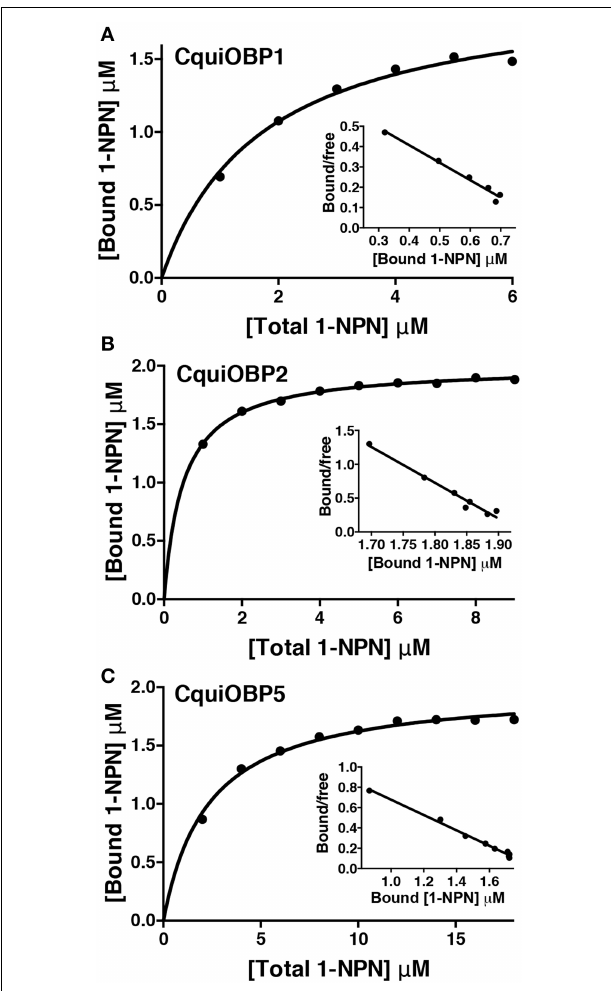
FIGURE 1 | Titration of OBPs with the fluorescence reporter NPN. (A) CquiOBP1, (B) CquiOBP2, and (C) CquiOBP5. The respective Scatcahrd plots are inserted under the